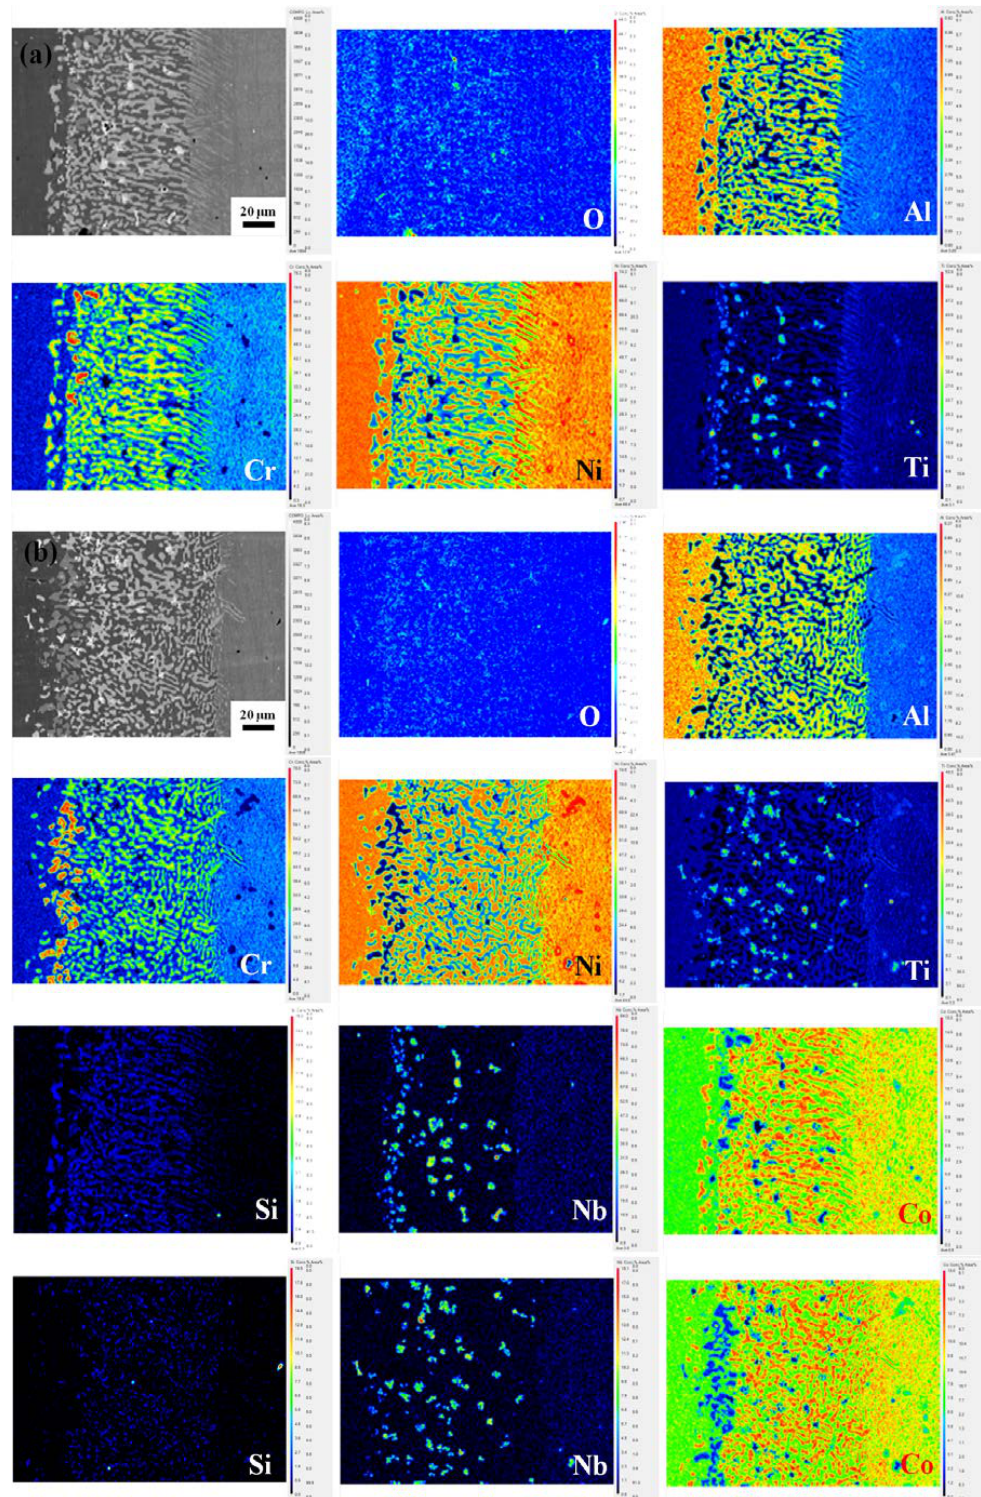
Figure 7. Electron probe microanalysis (EPMA0 elemental mappings of aluminide coating on IN738 after being oxidized at 1050 °C for 150 h: ( a ) in air plus water vapour and ( b ) in air.